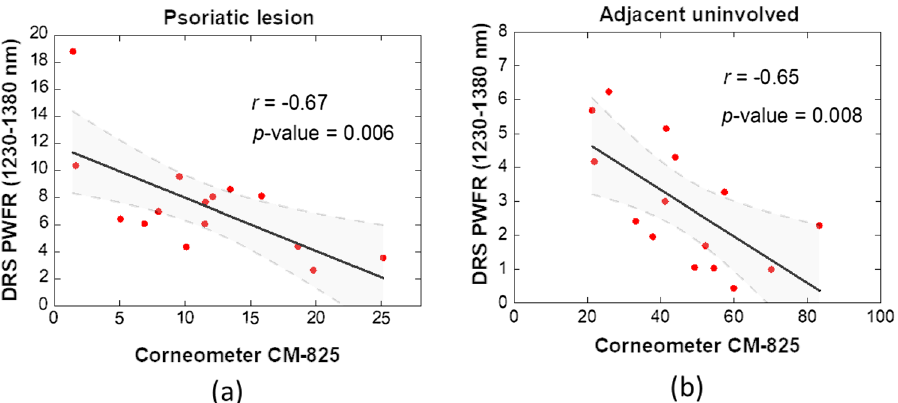
Figure 1. Correlation plots of the pure water fitting residuals at the first water absorption overtone obtained from the DRS system and the Corneometer hydration readings for ( a) the psoriatic lesion sites and ( b ) their adjacent normal sites. The r values indicate the Pearson correlation coefficients. Shaded domain represents 95% confidence band. A p -value greater than 0.05 represents that the fitted model is not significantly different from the model y = constant (no